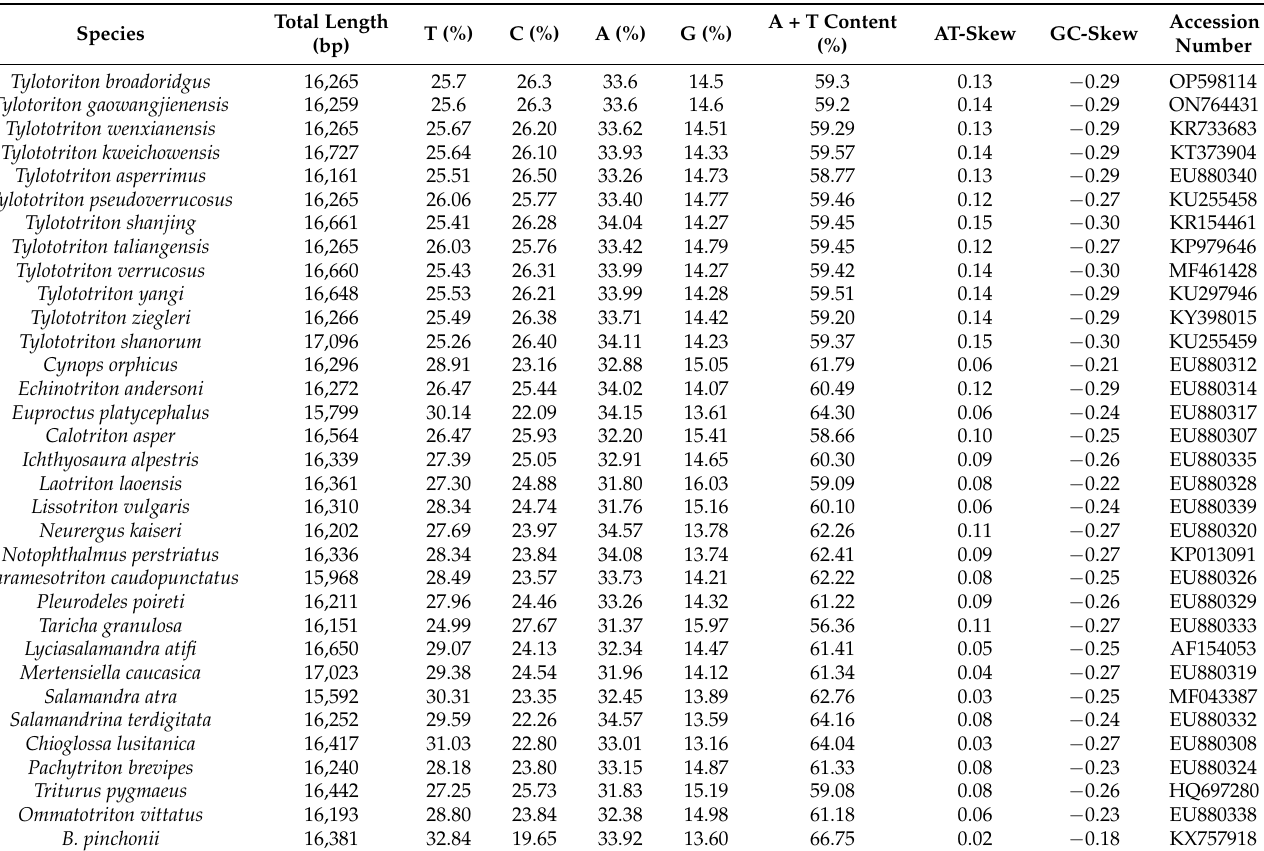
Table 2. Base composition (in percentages) of the mitogenomes of 33 species in Salamandridae that were used for phylogenetic analyses in this